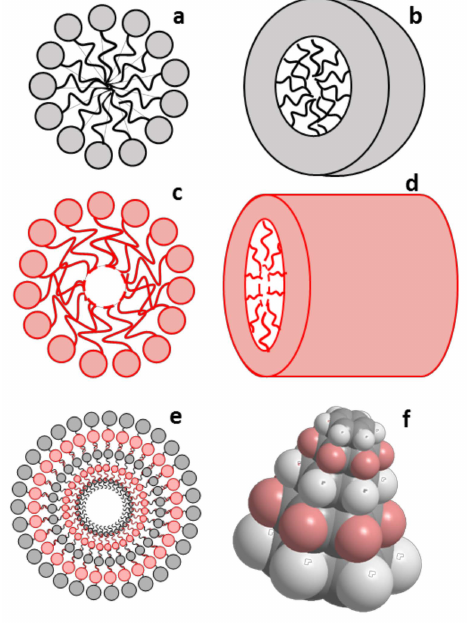
Figure 3. The 2D ( a , c , e ) and 3D ( b , d , f ) schematic representations of lignin aggregates shown as an assembly of amphiphiles with polar (balls) and non-polar (tail-like crooked lines) counterparts. Depending on the critical packing factor ( C PP ), the shape of the aggregate micelles can be spherical ( a , b ) or cylindrical ( c , d ). The positively charged polar counterparts of lignin are depicted by grey balls (in CL) and the negatively charged ones by pink balls (in LS). The interaction of positively and negatively charged lignins can form the observed cone-shaped aggregates ( e , f